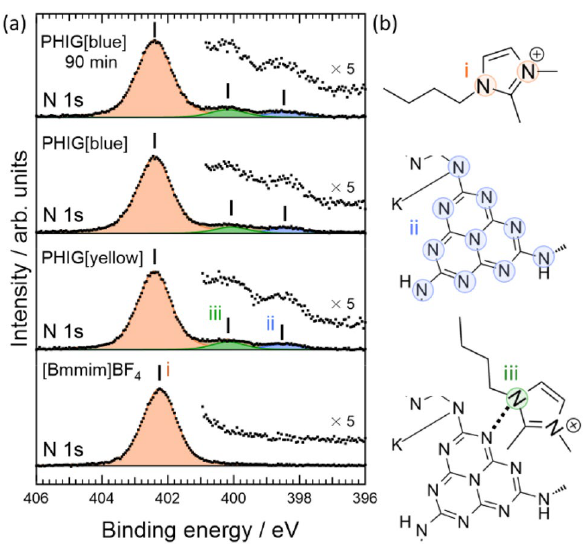
Figure 5. ( a ) XPS measurements of the N 1 s core level of [Bmmim]BF 4 , PHIG[yellow], and PHIG[blue]. The spectra for PHIG[blue] were acquired just after initiating light irradiation and 90 min after terminating irradiation. Shirley-type backgrounds were subtracted from the raw data. Each spectrum was normalized by the intensity of the N 1 s peak of the Bmmim cation at 402.25 eV. The labels i–iii on the spectra indicate the spectral features from nitrogen atoms in different environments, as illustrated in ( b ).